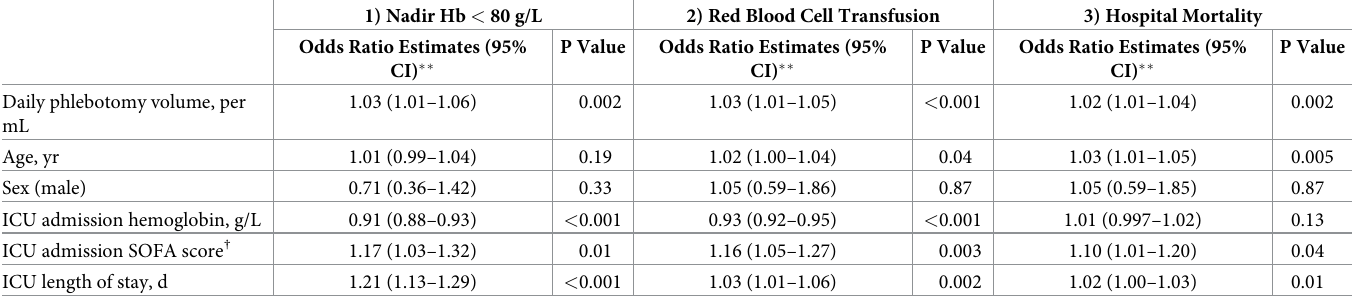
Table 3. Multivariable logistic regression for continuous and parametric predictors of 1) nadir hemoglobin < 80 g/L, 2) red cell transfusion in the ICU, and 3) hos- pital mortality. N = 384 after exclusion of major bleeding events �